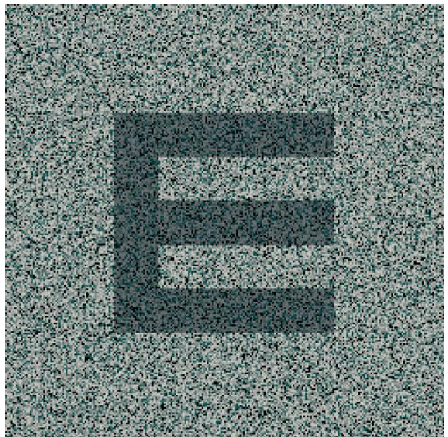
Figure 3. Example of a random-dot stimulus. The dark “E” represents the section of the image that is perceived in depth when seen by subjects with an appropriate binocular vision.